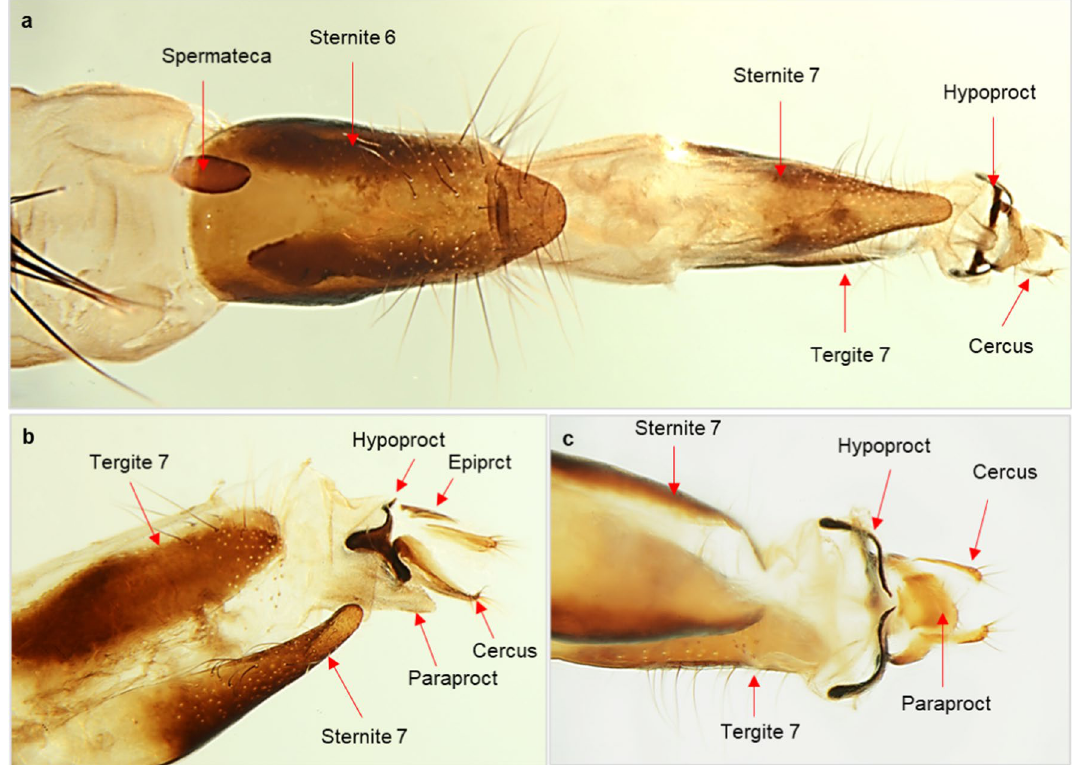
Fig. 3 Ovipositor of female of E. segregate : a ventral view; b lateral view; c dorsal